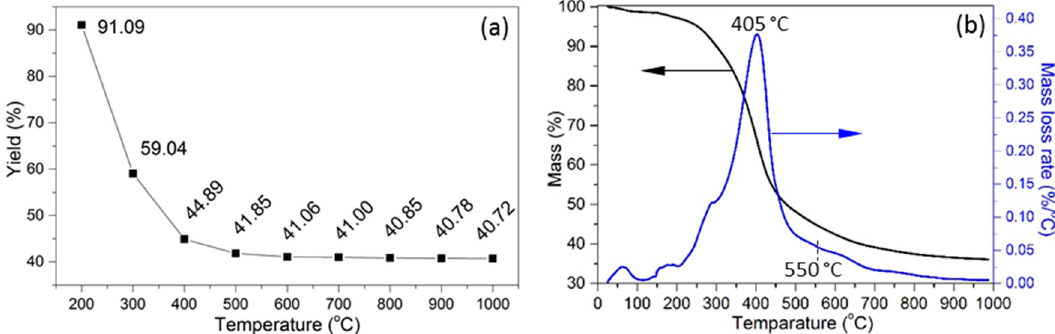
Figure 1. Thermal analysis of KL ( a ) KL-X yield at different temperatures, ( b ) TG and DTG curves.